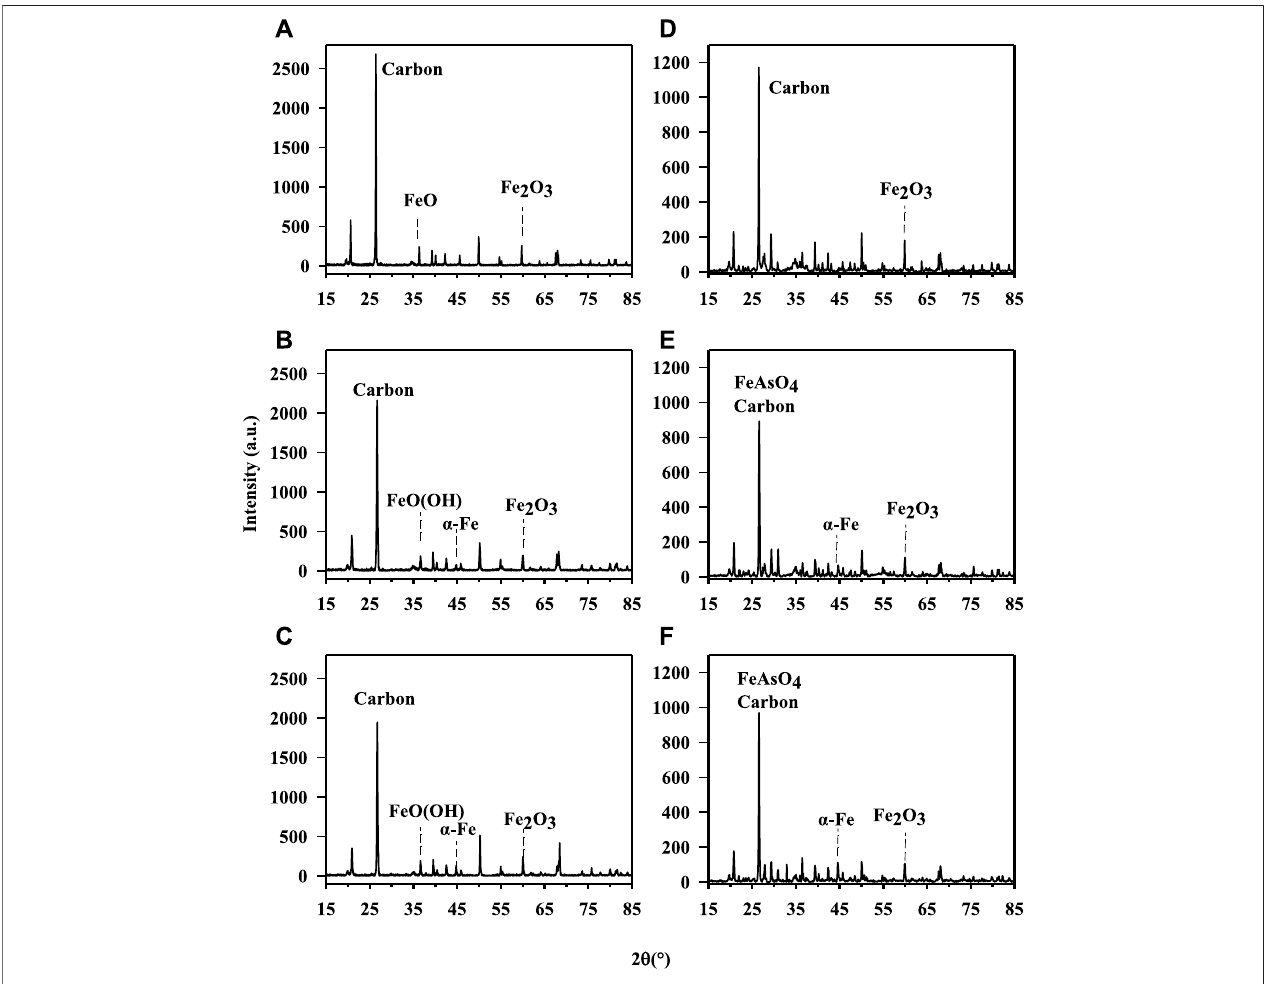
FIGURE1| X-raydiagramofuntreatedandtreatedsoilswithdifferentnZVIdosages. (A) soilA. (B) soilAtreatedwith1%nZVIfor56 days. (C) thesoilAtreatedwith 2% nZVI for 56 days. (D) soil B. (E) soil B treated with 1% nZVI for 56 days. (F) soil B treated with 2% nZVI for 56 days.